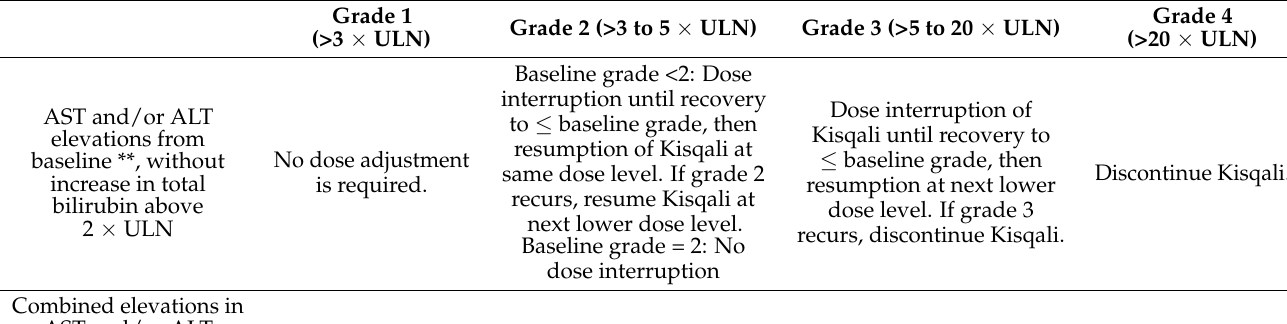
Table 2. Dose modifications and management of hepatobiliary toxicity of ribociclib, according to ribociclib US prescribing information, accessed in March